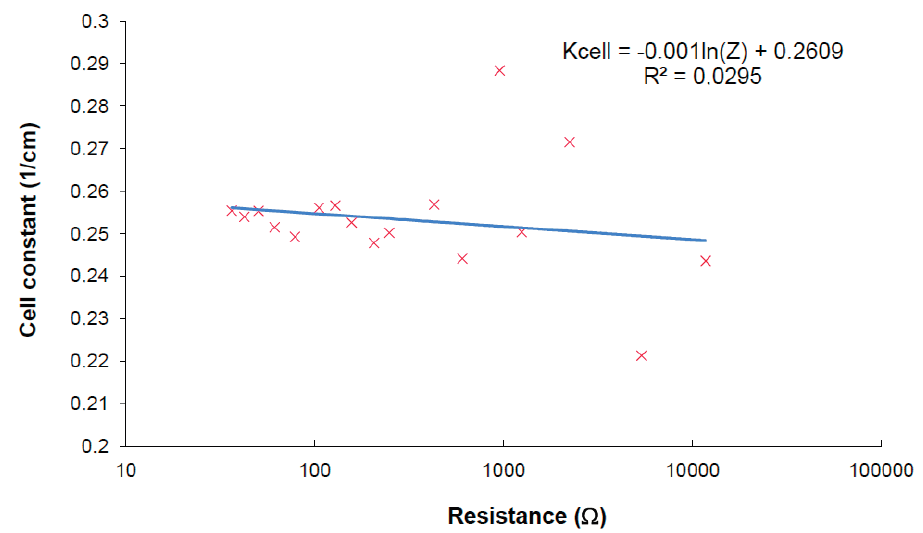
Figure 9. Verification of cell constant deviation when the developed method is used for